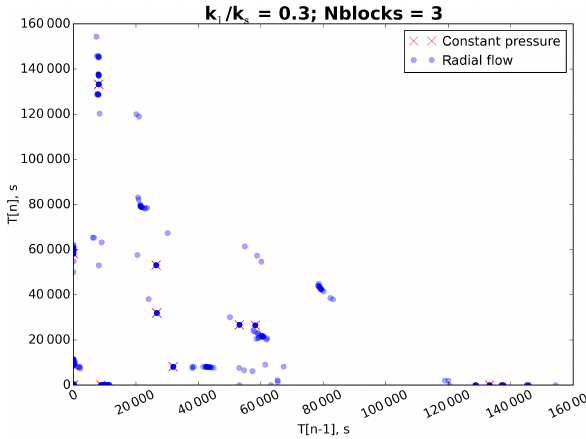
Figure 34. Iteration map of recurrence intervals of seismic events; T n denotes the time interval between the n th and ( n + 1)th events. The map includes events that occurred at time t ≥ 8 × 10 6